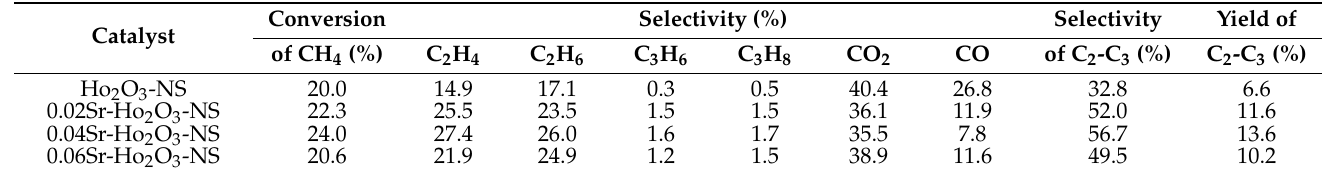
Table 1. Reaction data of the Ho 2 O 3 -NS and Sr-Ho 2 O 3 -NS catalysts at 650 ◦ C.